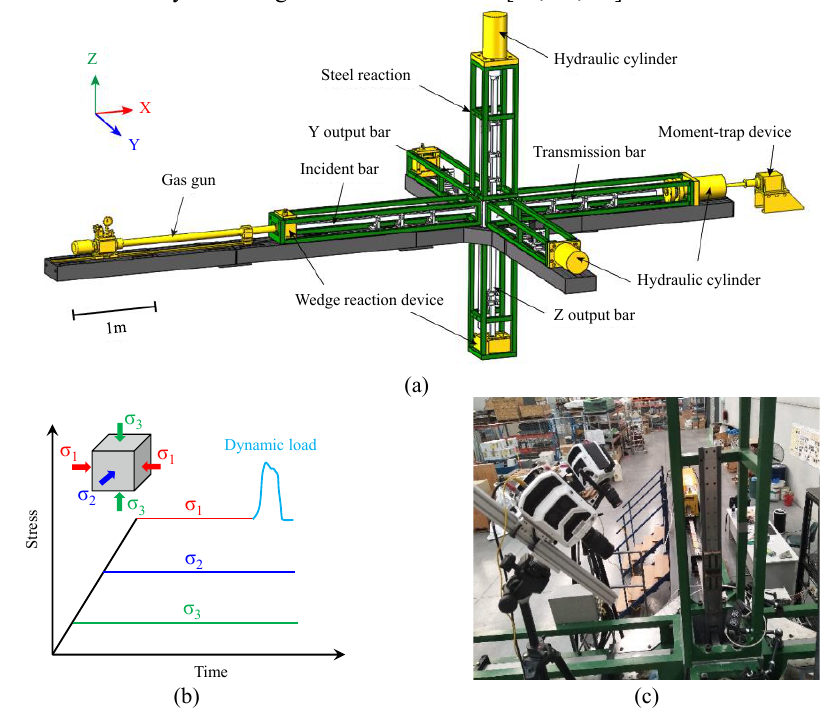
Fig. 2. (a) Triaxial Hopkinson bar system [10], (b) a typical loading path [11] and (c) 3D-DIC system by two high-speed cameras [12].